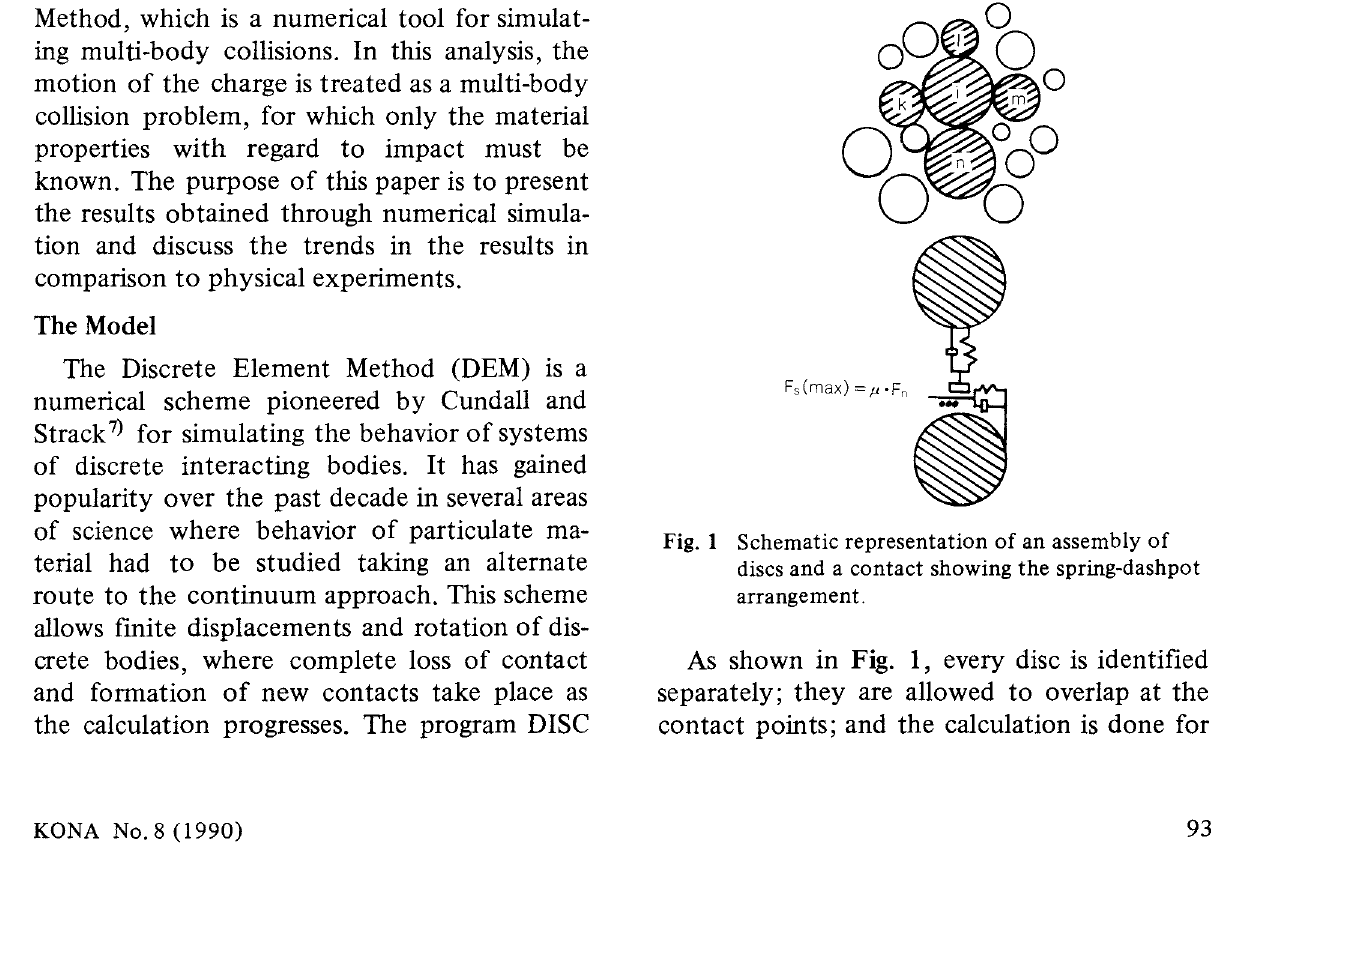
Fig. 1 Schematic representation of an assembly of discs and a contact showing the spring-dashpot